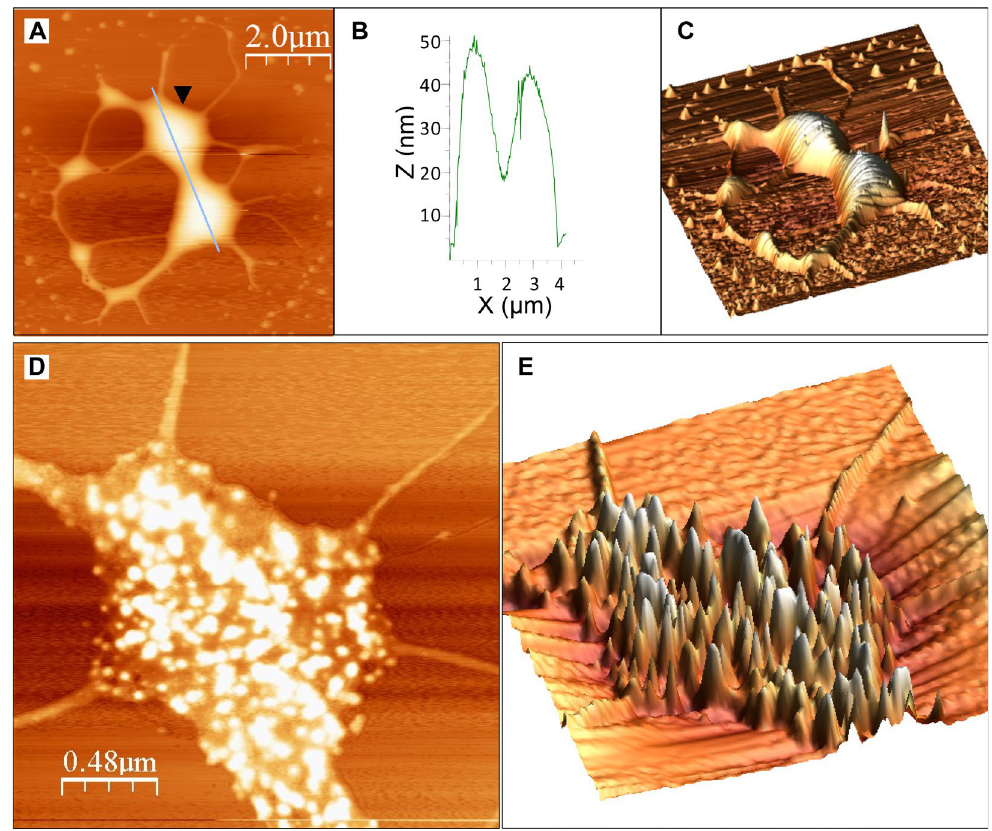
Figure 7. Hierarchy of kDNA condensation: LCF are assembled into few high order condensation centers. (A) 2D-display of an AFM scan presenting a kDNA network, which was interacted with 150 nM KAP3 (Bar = 2.0 µm). (B) A profile of the AFM scan (path is indicated by a line crossing the 2D image). (C) A 3D-display of the network presented in (A) . (D) Higher resolution scanning of one of the top condensation centers in the network, marked by an arrowhead in (A) . (E) A 3D-display of condensation center, marked by the arrowhead in (A)